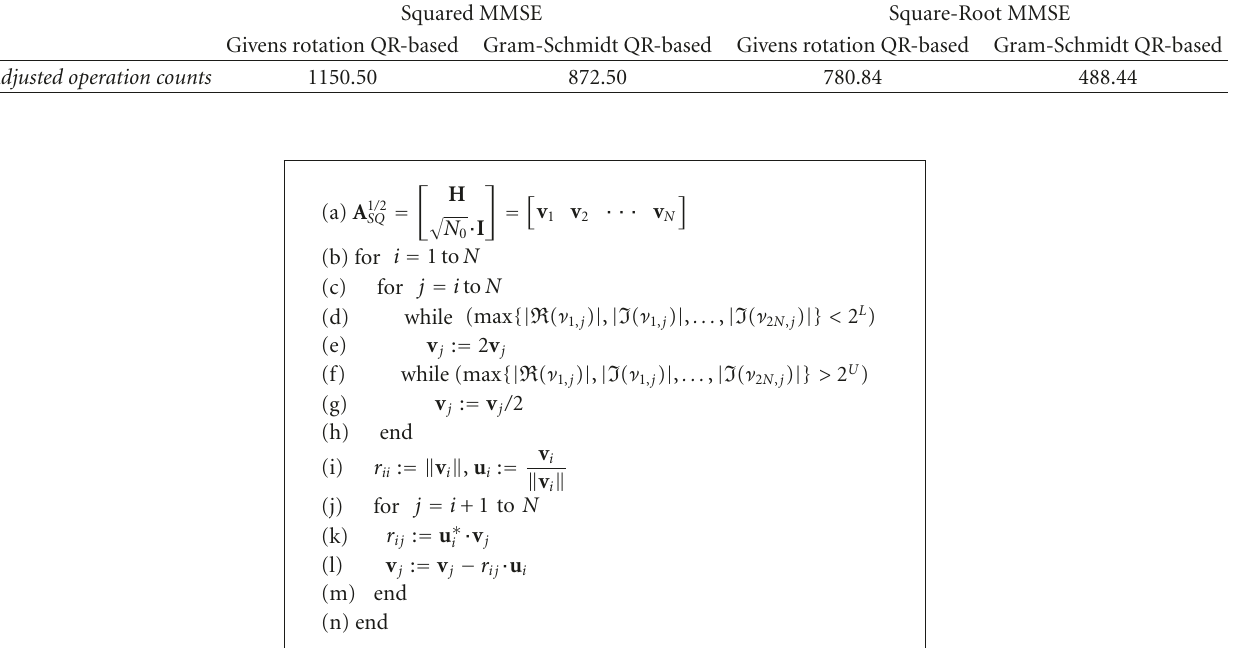
(cid:2) n (4 × 4 detector).